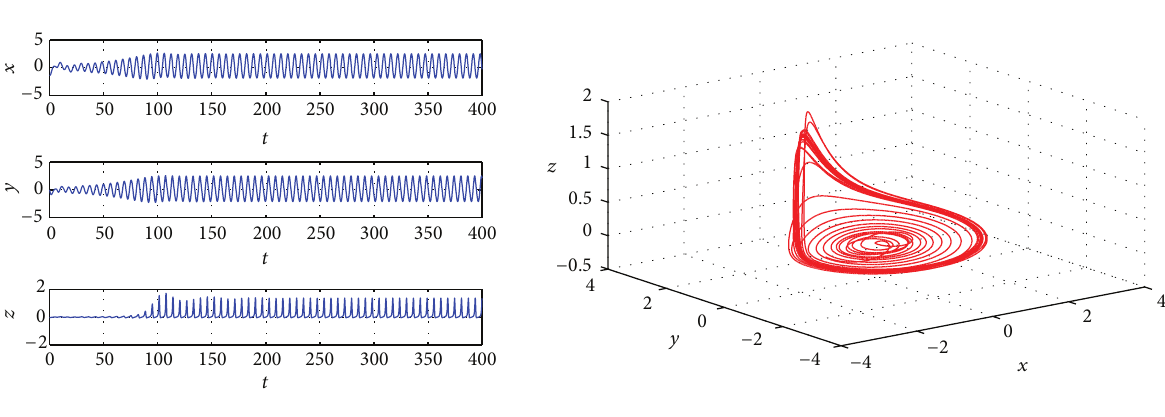
Figure 6: The trajectories and phase graphs of system (61) with 𝜏 = 6.3804 when 𝐾 = −1 .